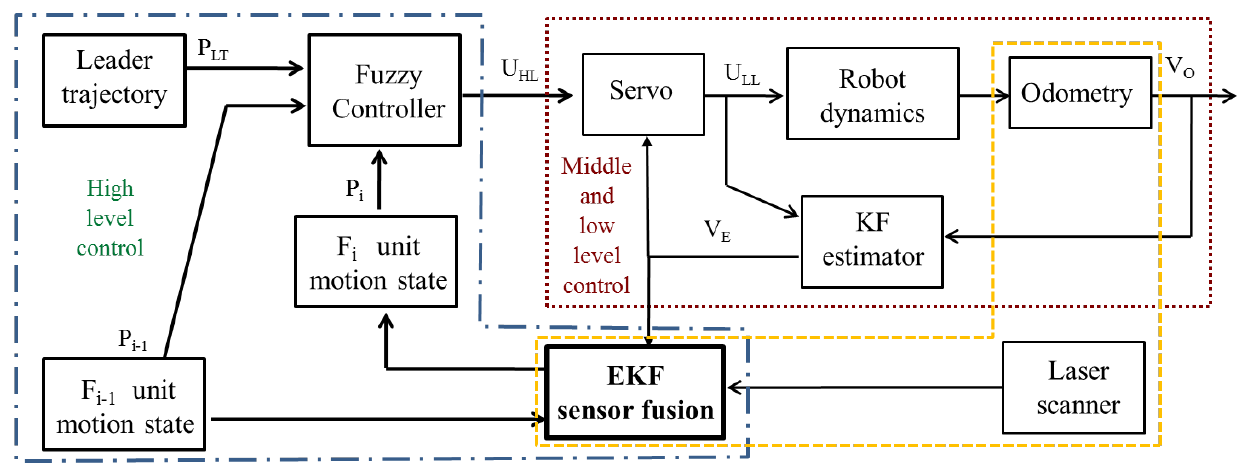
Figure 3. Organization of the control levels and their relation with the sensorial systems included in each follower